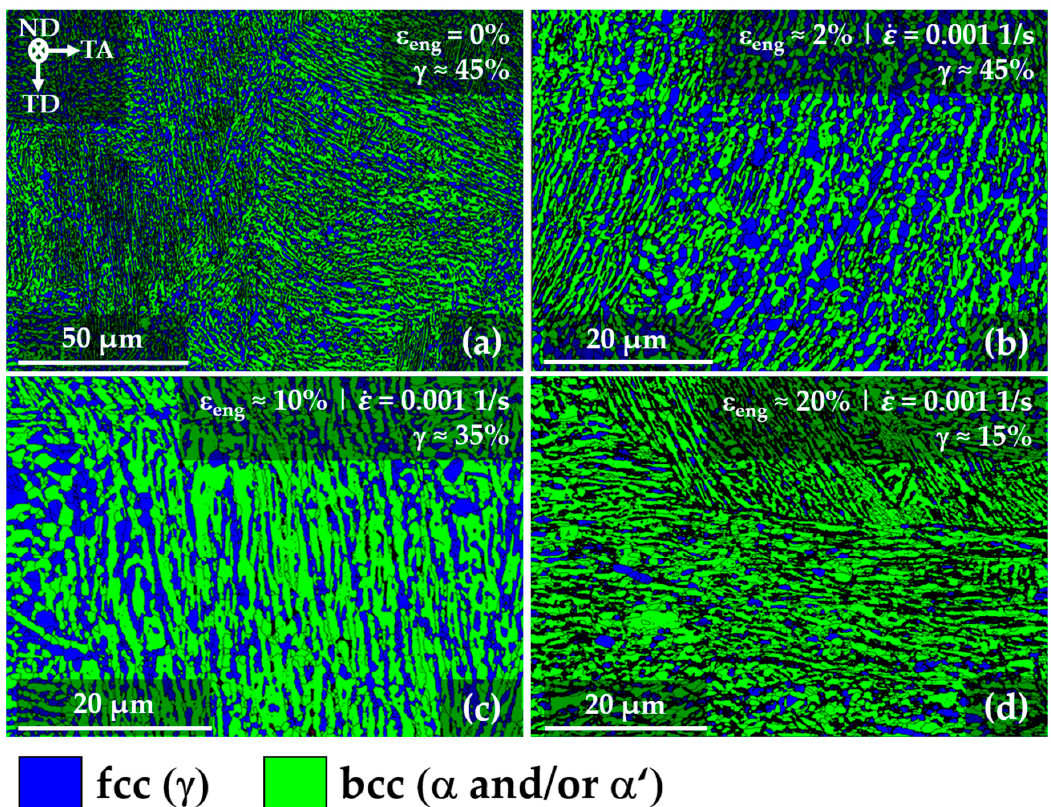
Figure 4. Electron backscatter diffraction (EBSD) phase maps of the investigated MMnS ( a ) before deformation and after straining to ε eng of ( b ) 2%, ( c ) 10%, and ( d ) 20% at 0.001 1/s. Green areas indicate a body-centered cubic crystal structure, α and/or α ’, whereas blue areas indicate face-centered cubic austenite, γ .